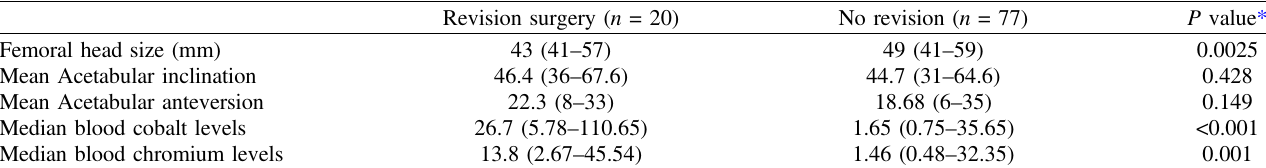
Table 4. Association of revision surgery with imaging fi ndings and blood ion